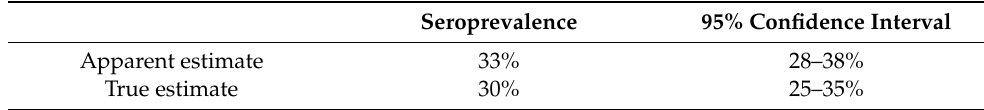
Table 2. Apparent and true seroprevalence estimates for Coxiella burnetii in the abattoir survey, South Africa,